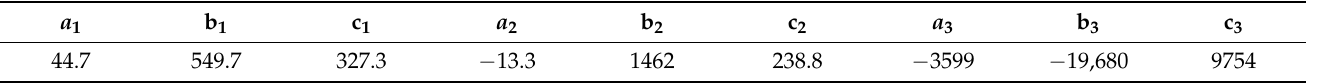
Figure 12. Gaussian regression of transmittance (W = 200 nm, H = 400 nm). (The area under curve is provided for visual clarity.) Table 2. The transmittance coefficients by Gaussian regression at n =